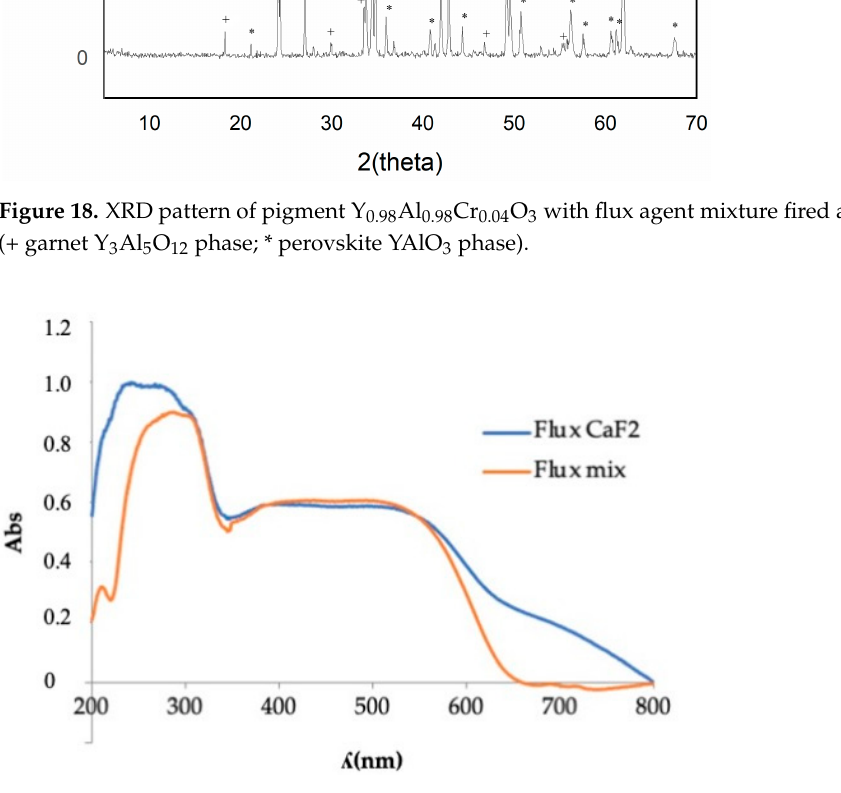
Figure 19. UV-Vis spectrophotometry of pigment Y 0.98 Al 0.98 Cr 0.04 O 3 fired with different flux agents.